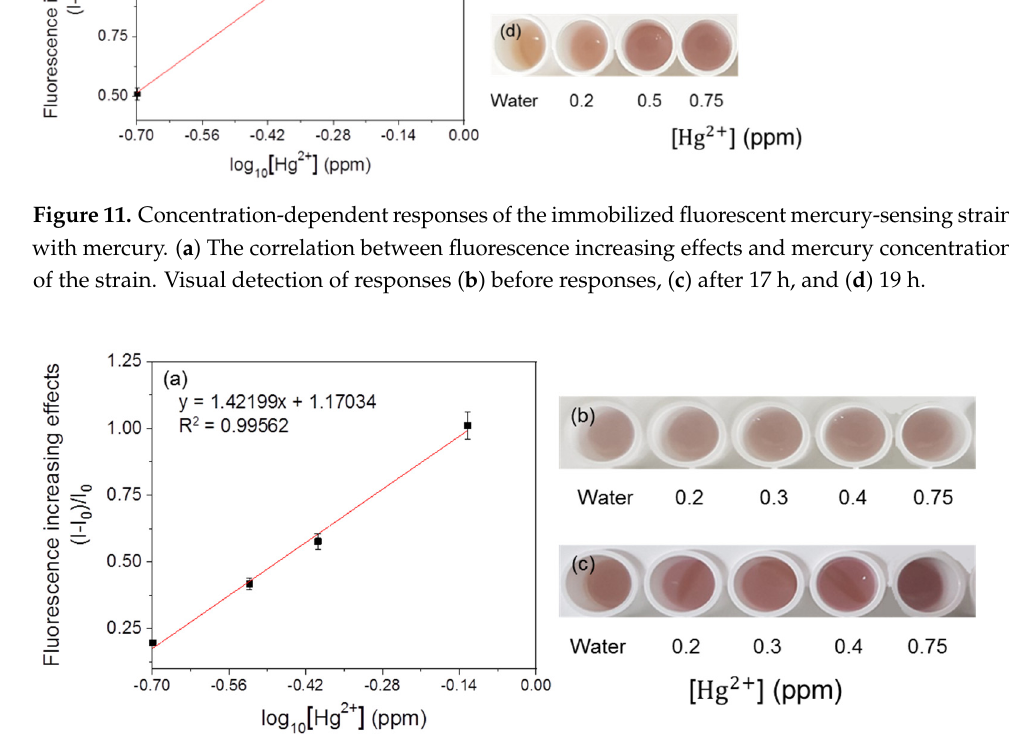
Figure 12. Effects of 3 h incubation in M9 medium on fluorescent value (RFU). ( a ) The correlation between fluorescence increasing effects and mercury concentration of the immobilized strain. Visual detection of responses ( b ) before responses and ( c ) after 19 h.